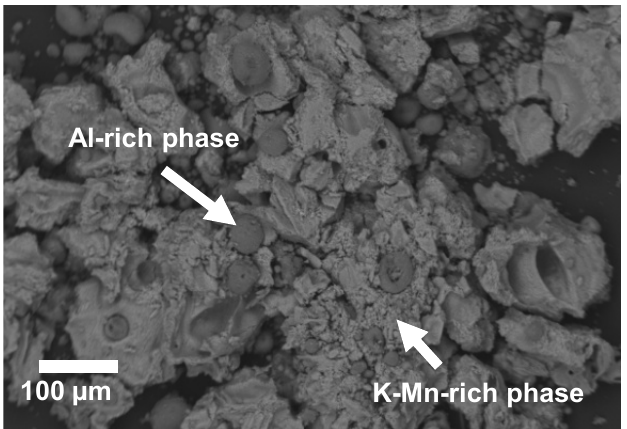
Figure 1. SEM image (BSE) of KMnO and the K-Mn-rich matrix are indicated.